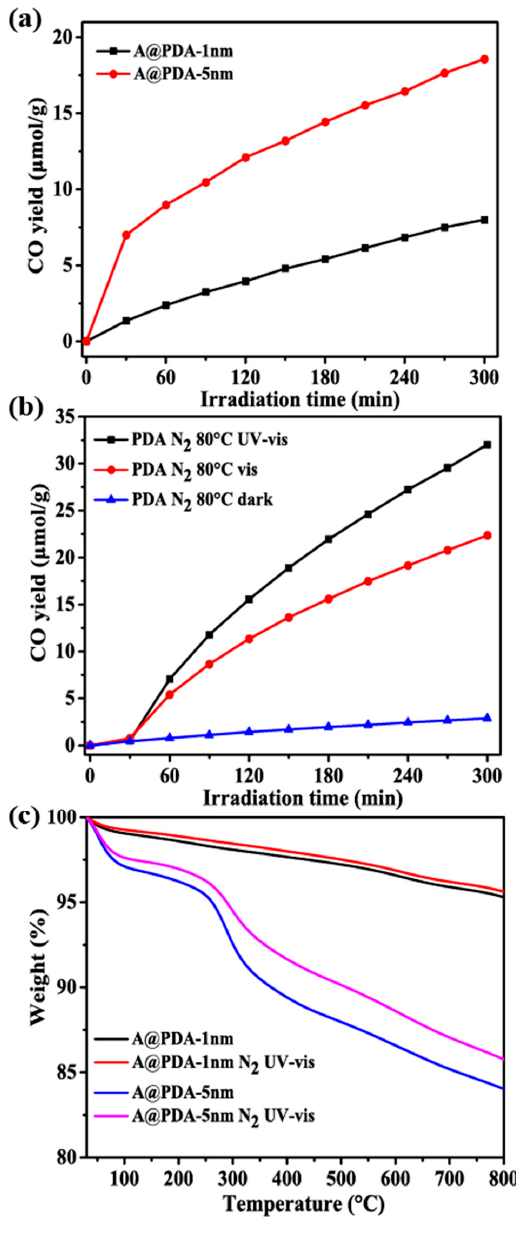
Figure 3. ( a ) The control experiments of A@PDA-1 nm and A@PDA-5 nm under UV-vis light in N 2 ; ( b ) CO yields for the PDA in N 2 under UV-vis light and visible light and in dark; and ( c ) TGA for the